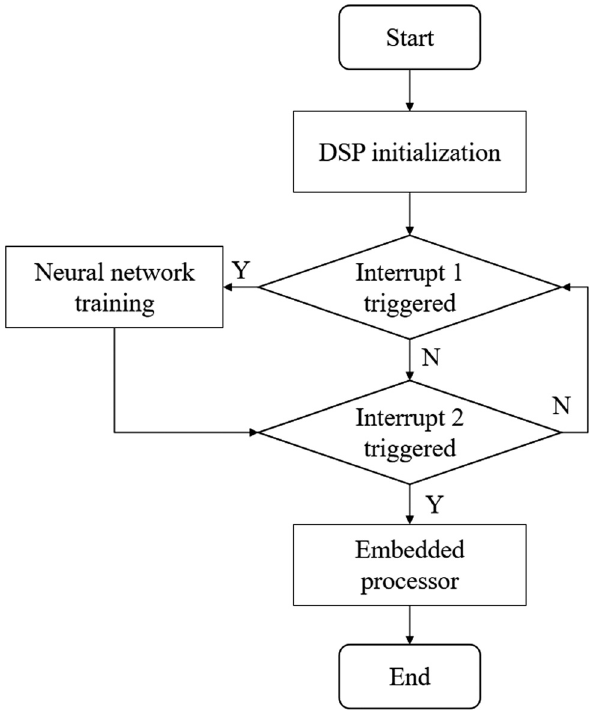
Figure 5: Basic fl ow chart of software